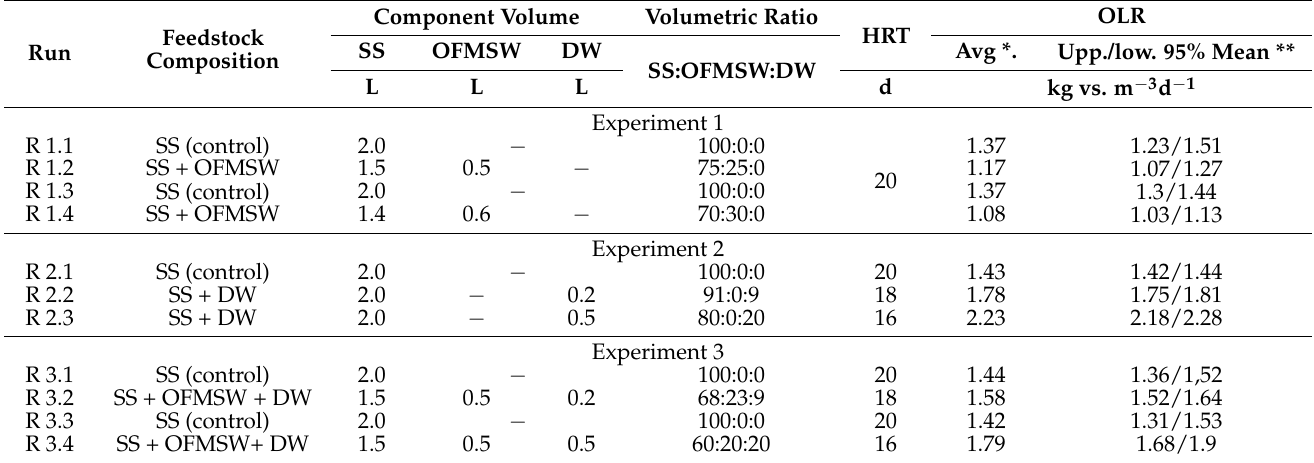
Table 2. Operational conditions used in